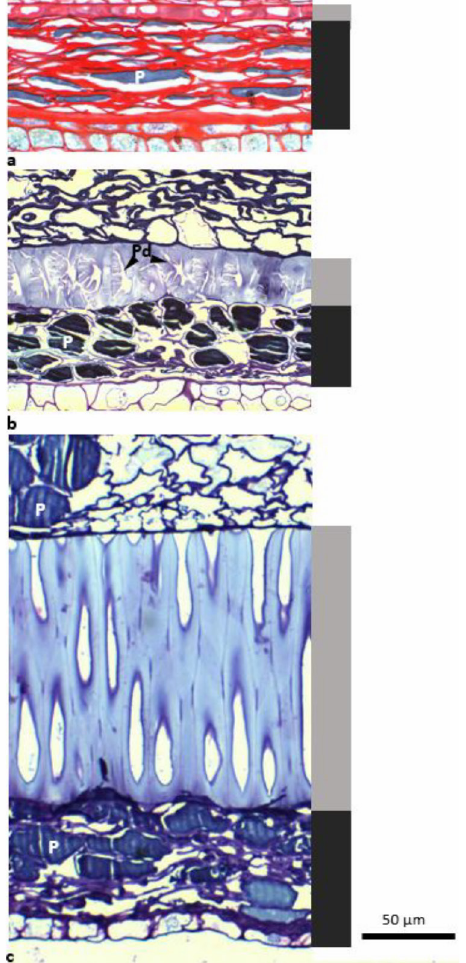
Fig. 3: Longitudial sections through the tegmen of T. cacao (a), T. grandi- florum (b) and T. bicolor (c) P: polyphenol cells; Pd: cell wall perforation for plasmodesmata Marking (right margin): exotegmal sclereid or palisade layer (light grey), parenchyma of the tegmen (black) Semi-thin sections, stained with Safranin/Fast green (a) and Toluidine Blue O (b,